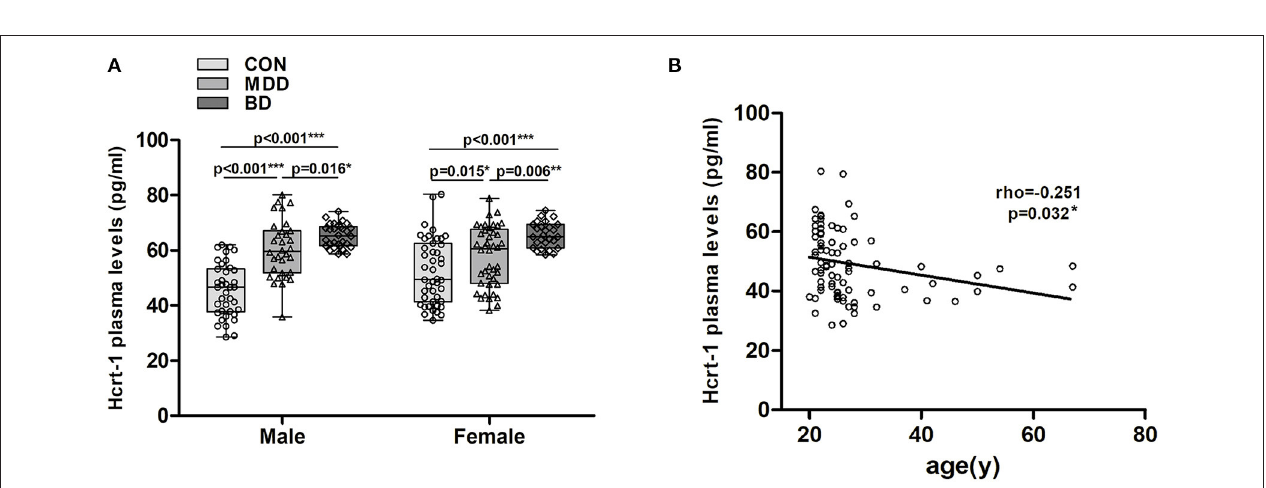
FIGURE 2 | Changes in plasma hypocretin-1 levels in mood disorder patients and controls with respect to mood disorder subgroups, sex, and age. (A) In males, a significant increase in plasma hypocretin-1 levels was found in MDD ( n = 32) and BD ( n = 29) patients compared to controls ( n = 38), and BD patients had a higher hypocretin-1 level than MDD patients. A similar difference was also observed in the female groups. (B) In controls, there was a significant negative correlation between plasma hypocretin-1 levels and